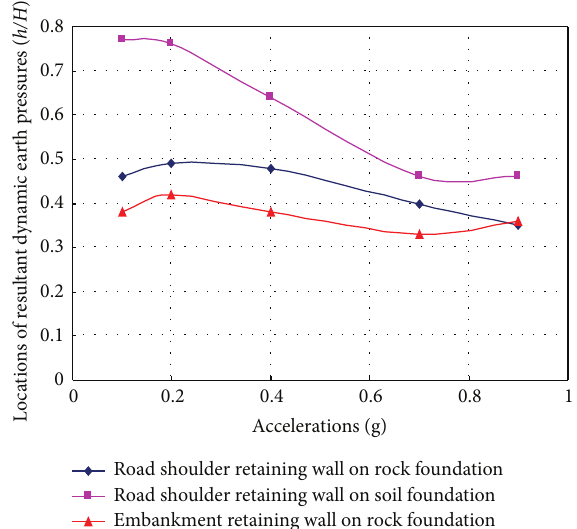
Figure 12: Locations of resultant dynamic earth pressures ( h/H ).